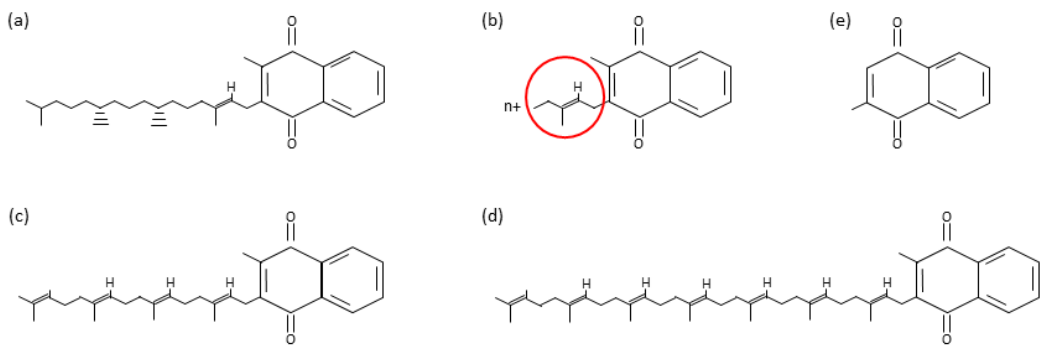
Figure 1. Main vitamin K metabolites. Phylloquinone ( a ), menaquinones, with the prenyl group highlighted with a red circle ( b ), menaquinone 4 ( c ), menaquinone 7 ( d ), and menadione ( e ).